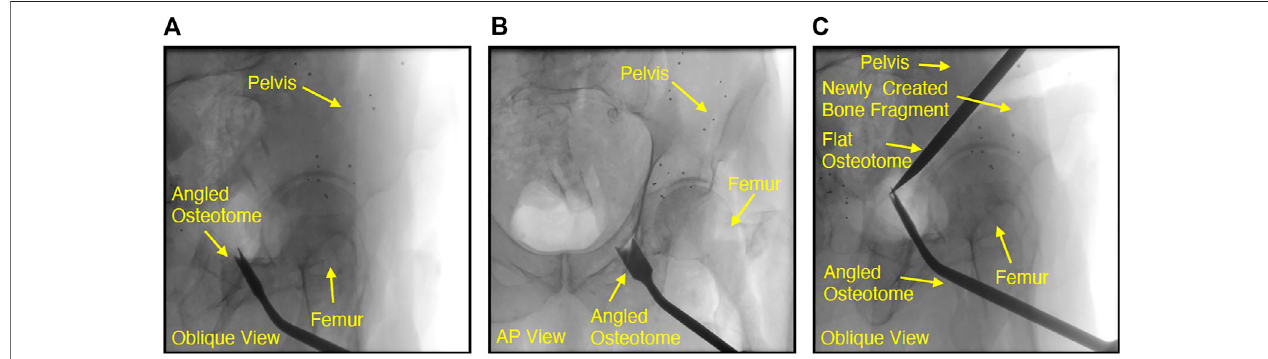
FIGURE 4| Fluoroscopic images ofchiseling performed during acadaveric periacetabular osteotomy procedure. Acut alongthe ischium ofthe pelvis isshown by theoblqiueviewin (A) .Duetothedif fi cultywithmanuallyinterpretinglateralorientationsofthetoolinanobliqueview,theverynext fl uoroscopyframewascollectedatan approximate anterior-posterior (AP) view, shown in (B) . Although the osteotome location wascon fi rmed by changing viewpoints, the process of adjusting the C-arm by such alargeoffset can potentiallyincrease operative time or cause theclinician to lose some context in theprevious oblique view. Another oblique view isshown in (c),wherethe fl atosteotomeisusedtocompletetheposteriorcut,resultinginthecreationoftwobonefragmentsfromthepelvis.In (C) ,theangledosteotomewasleftin the fi eld of view and used as a visual aid for navigating the fl at chisel and completing the osteotomy.